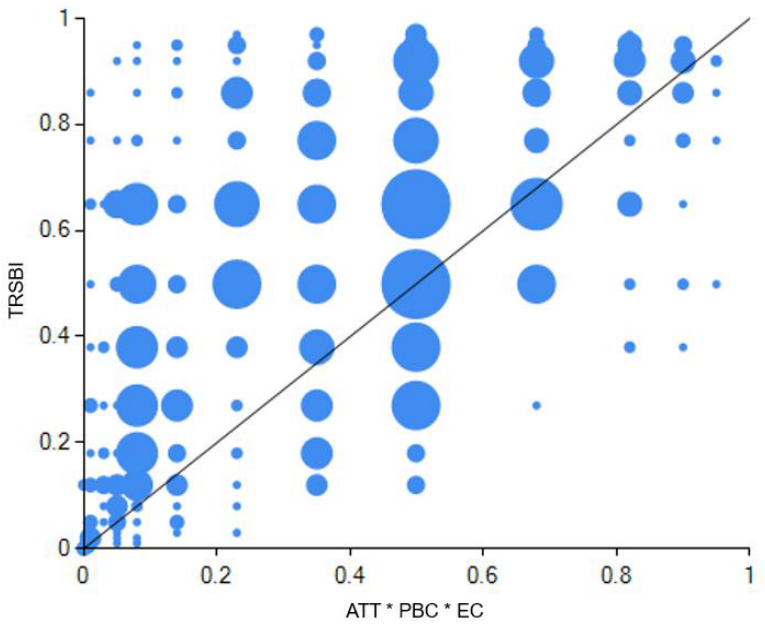
Figure 5. Configuration 3 explanation in the mode of tourist resource-saving behavioral intentions.